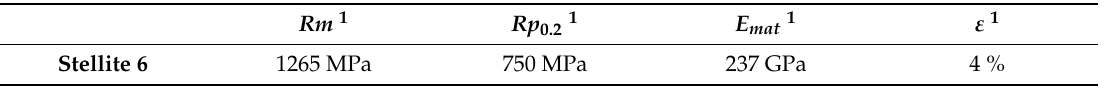
Table 2. Nominal values of the stress of the Stellite 6 spray at room temperature.